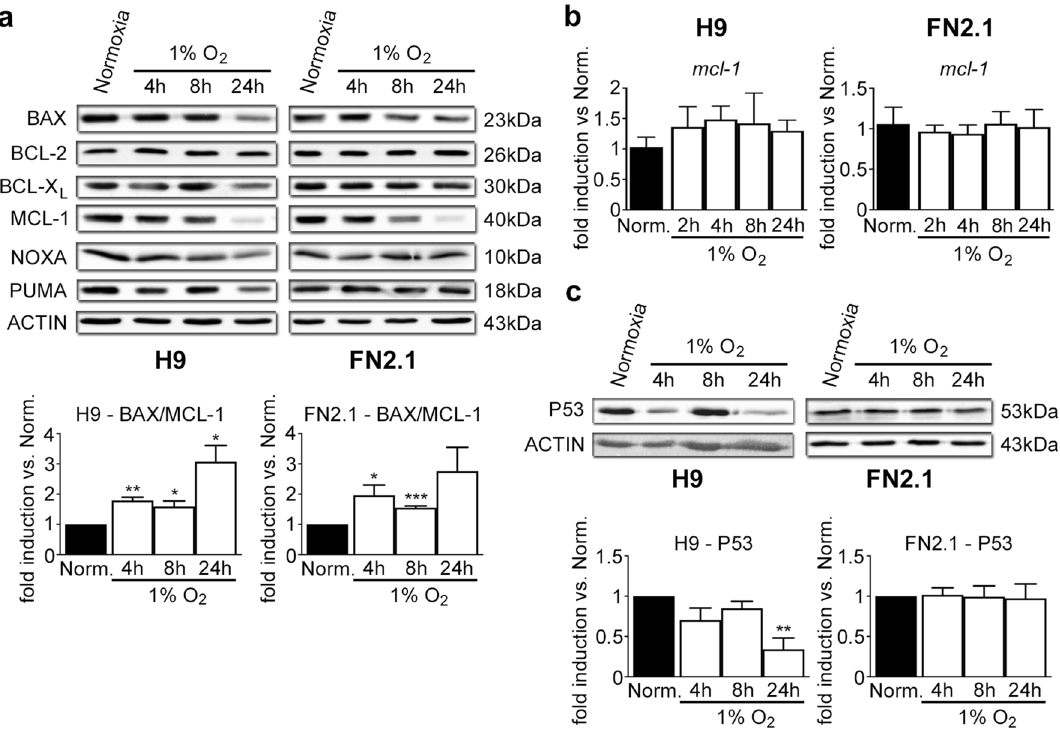
Figure 5. BCL-2 family members and P53 protein expression levels. Expression levels of ( a, c ) BCL-2 family members, including BCL-X L (anti-apoptotic), BCL-2 (anti-apoptotic), MCL-1 (anti-apoptotic), BAX (pro- apoptotic), NOXA (pro-apoptotic) and PUMA (pro-apoptotic) ( a ) or P53 ( c ) were analyzed by western blot in H9 and FN2.1 cells at 4, 8 and 24 h upon 1% O 2 hypoxia treatment. ACTIN was used as loading control. Representative blots of three independent experiments are shown (original western blot images are